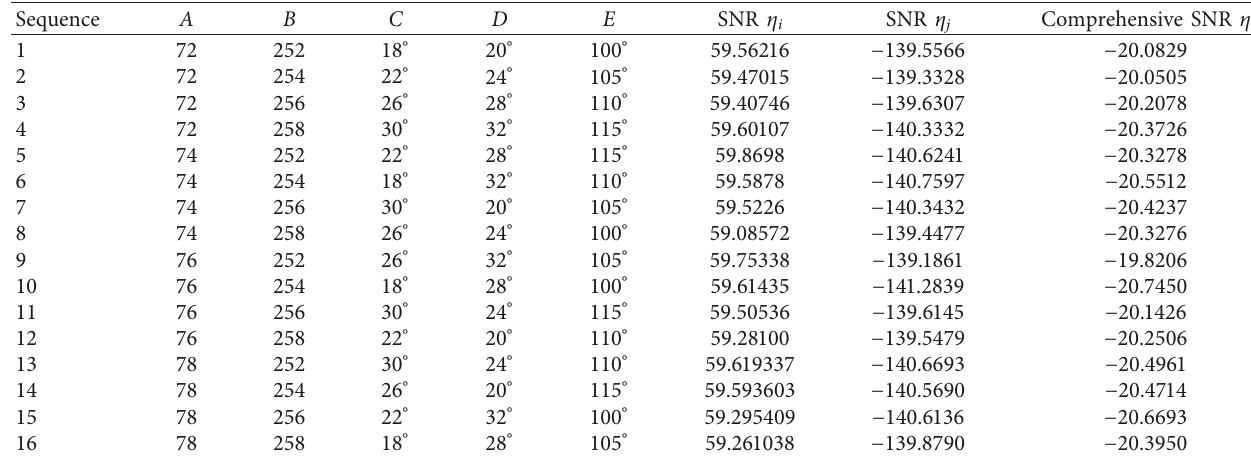
Table 13: Results of SNR calculation.